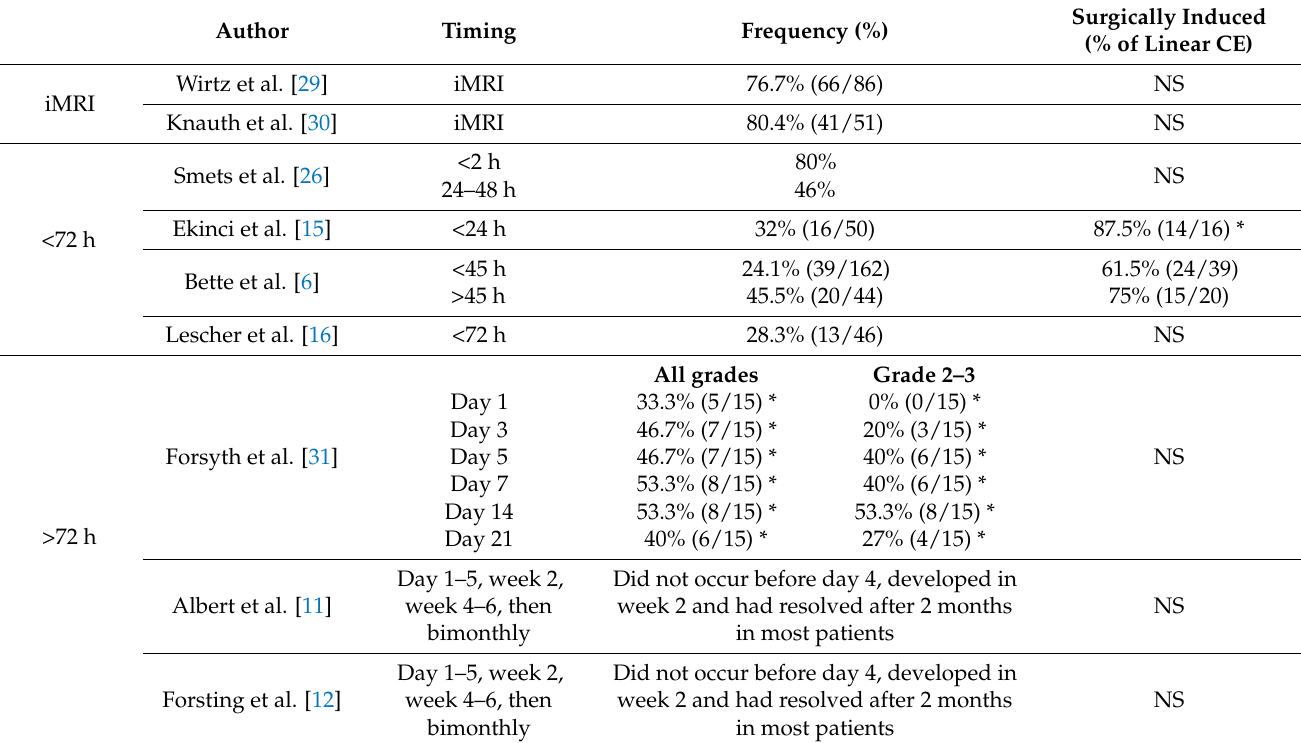
Table 2. Frequency of linear enhancements.